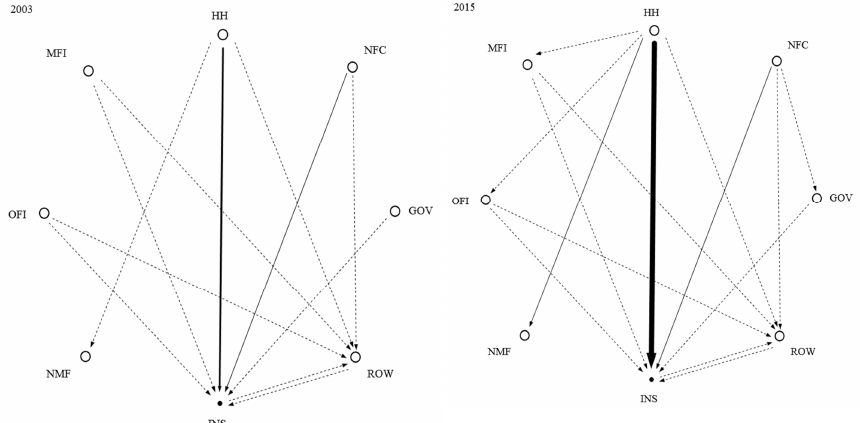
Figure 4. Flows of insurance, pensions and standardised guarantees in 2003 and